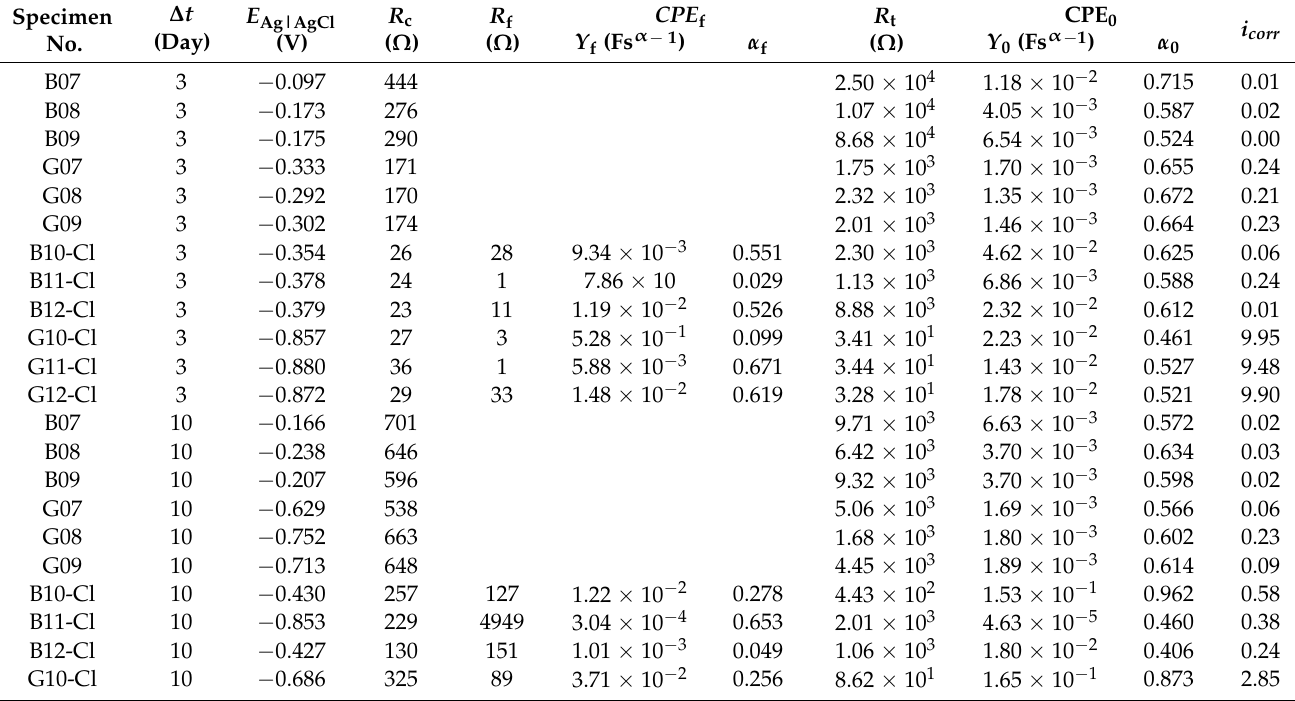
Table A4. Comparison of the results from analysing the impedance spectra of galvanized and black steel rebars φ 16 mm, made of steel grade B500SP, embedded in concrete with and without chlorides. The tests were conducted on days 1, 7, and 28 after setting the specimens in